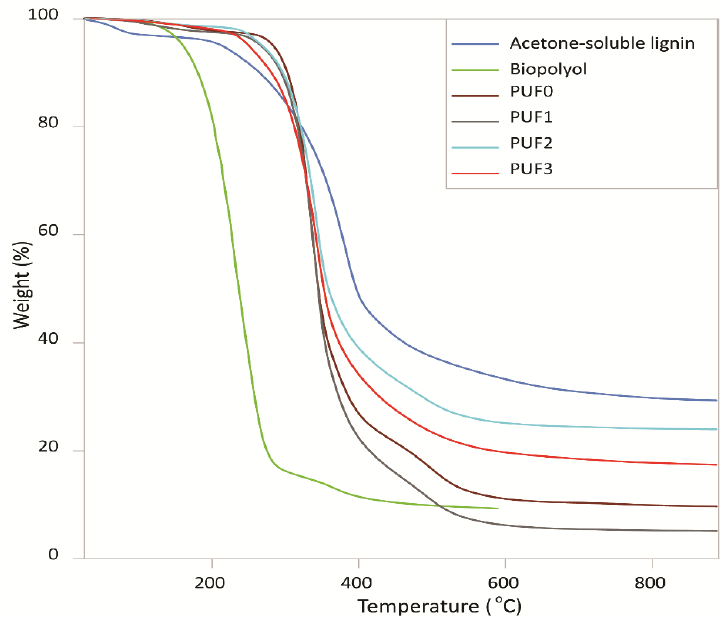
Figure 8. TGA curves of acetone-soluble lignin, optimal biopolyol, synthesized polyurethane foams.